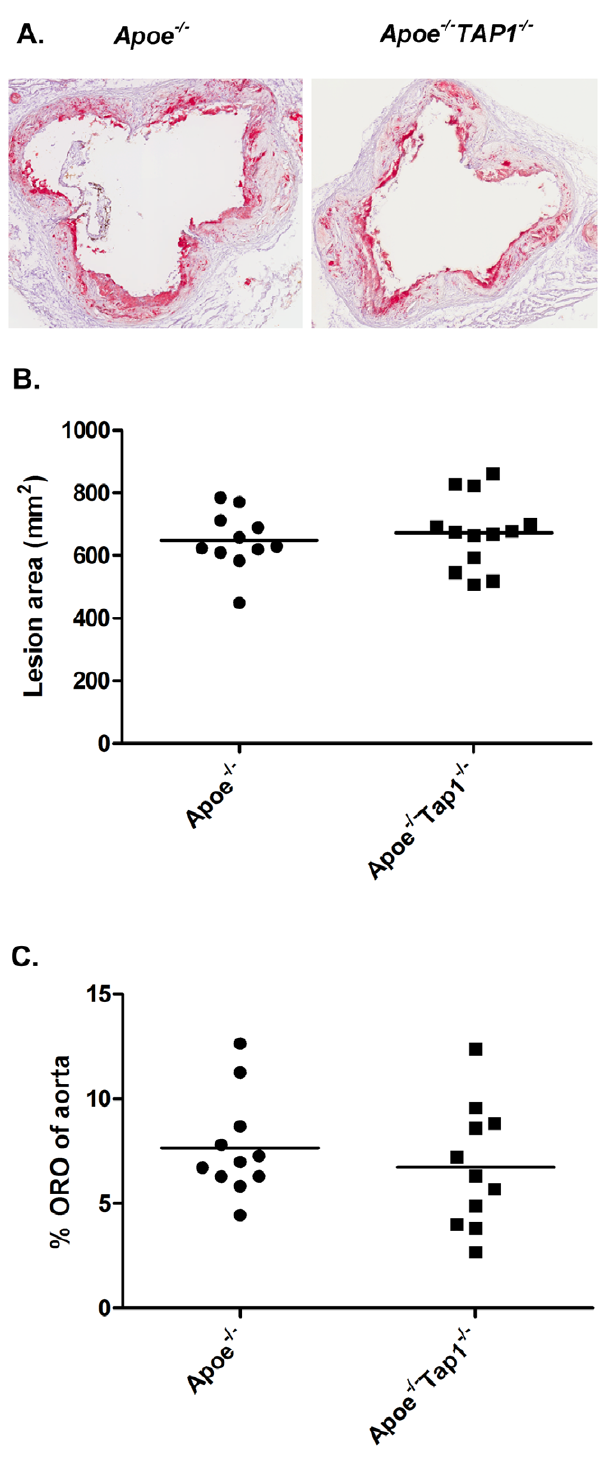
Figure 2. Plaque area in aortic root and aorta. (A) Representative images of plaques in the aortic root from one mouse in each group. Quantification of plaque area in the aortic root (B) and aorta (C) of Apoe 2 / 2 and Apoe 2 / 2 Tap1 2 / 2 mice fed high fat diet for 20 weeks. The tissues were stained with Oil red O (ORO) and analyzed by a blinded observer. Each dot in the figure represents one mouse.